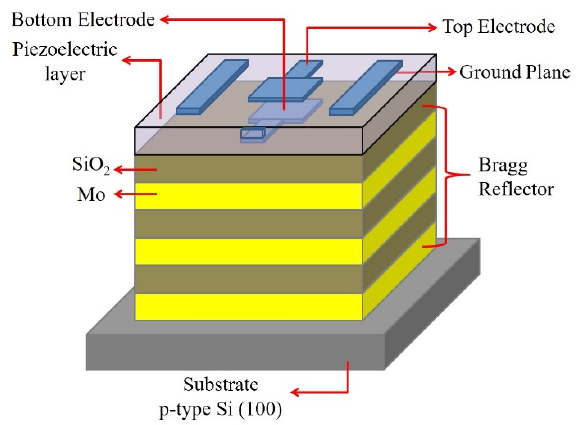
Figure 1. The structure of an SMR